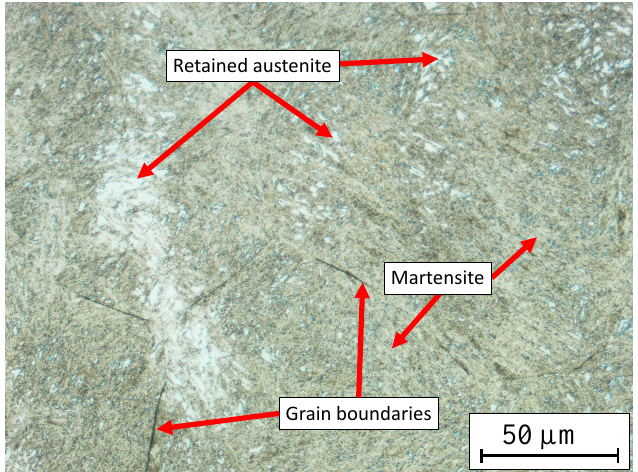
Figure 16. Selected micrographs (optical microscopy) of X30Cr13 of 1100°C and 1mm distance from the quenched end face using an etchant accoding to the work in [17] consisting of 925mL ethanol, 25g picric acid, and 50mL hydrochloric acid. The retained austenite is very well recognizable.